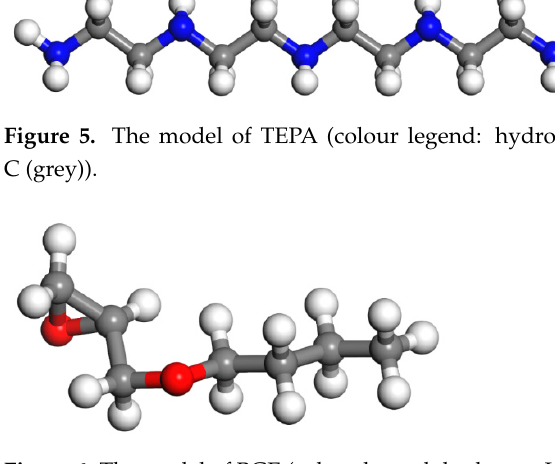
Figure 6. The model of BGE (colour legend: hydrogen H (white); oxygen O (red); carbon C (grey)).